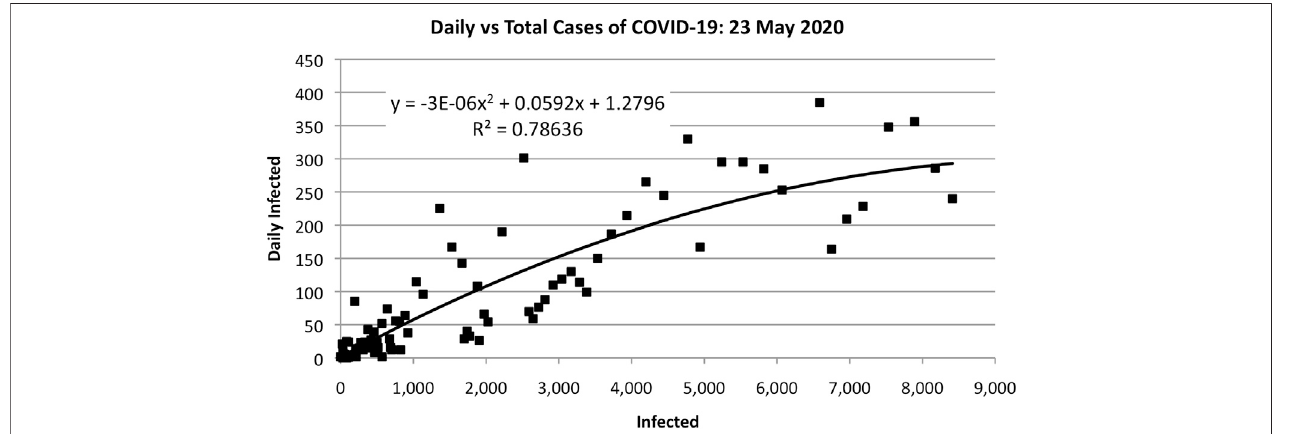
FIGURE 3 | Applying the quadratic Bass model to predict 28,360 total cases as of 23 May 2020.